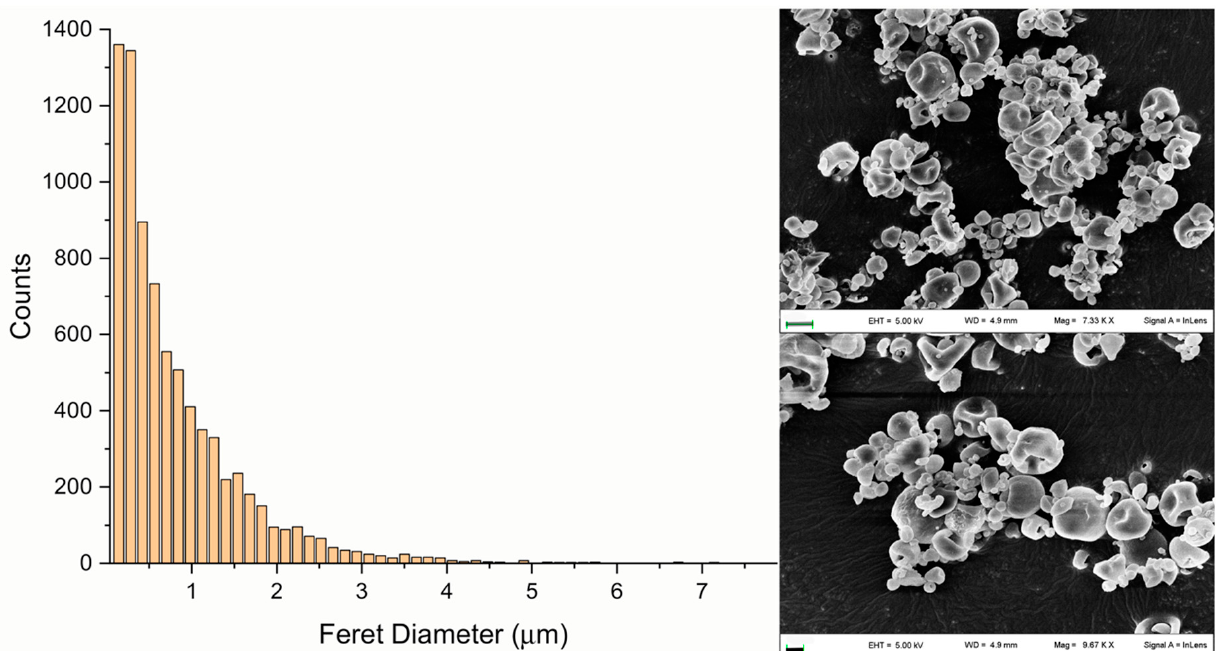
Figure 5. Feret’s size distribution ( left ) and morphology ( right ) of the chosen formulation corre-